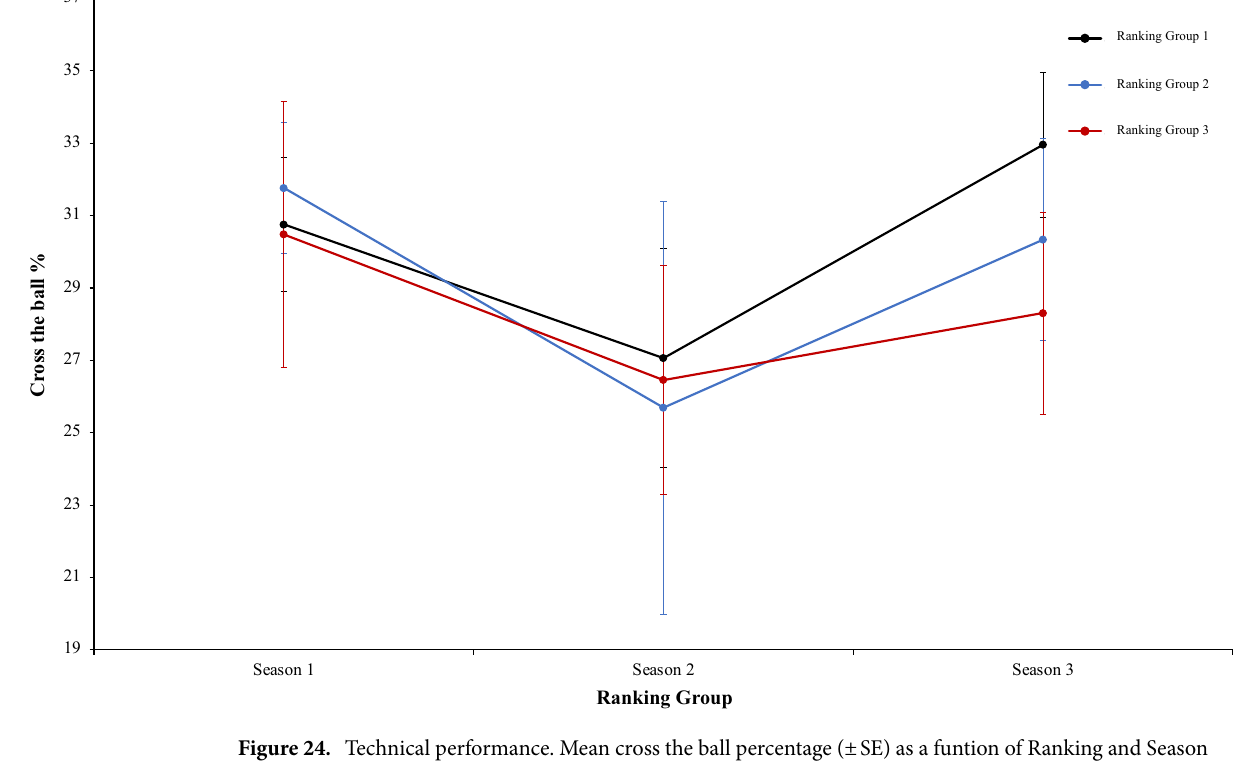
Figure 24. Technical performance. Mean cross the ball percentage (± SE) as a funtion of Ranking and Season Condition.